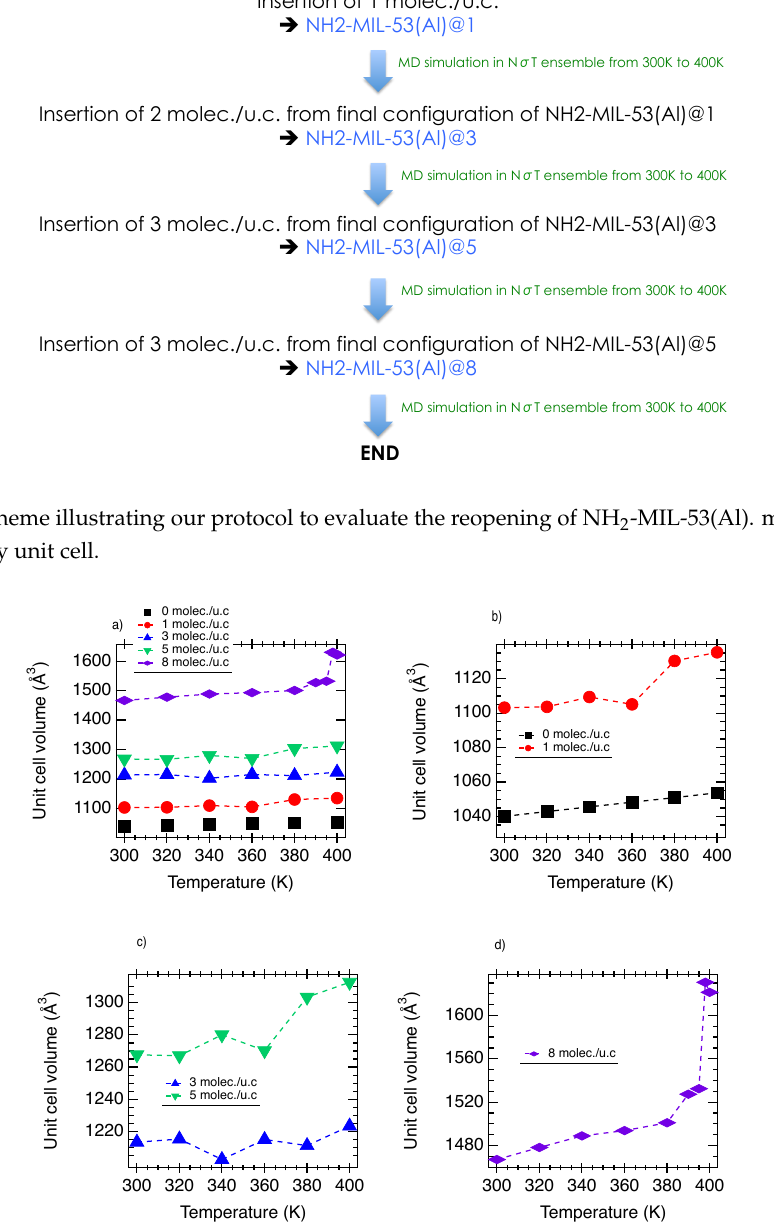
Figure 6. ( a ) Unit cell volume as a function of the temperature for 0, 1, 3, 5 and 8 molec./u.c.; ( b ) Unit cell volume as a function of the temperature for 0 and 1 molec./u.c.; ( c ) for 3 and 5 molec./u.c. and ( d ) for 8